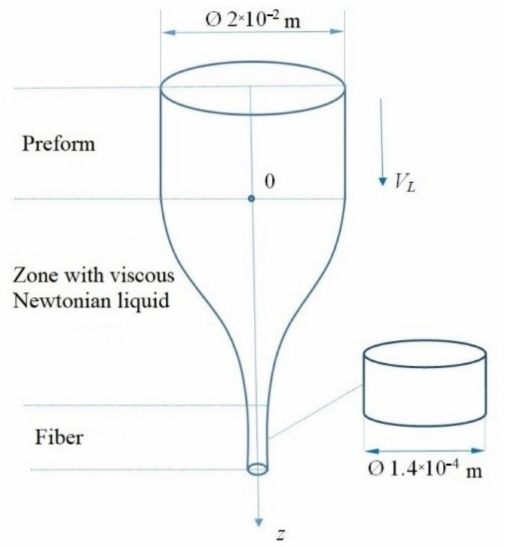
Figure 17. Scheme of optical fiber